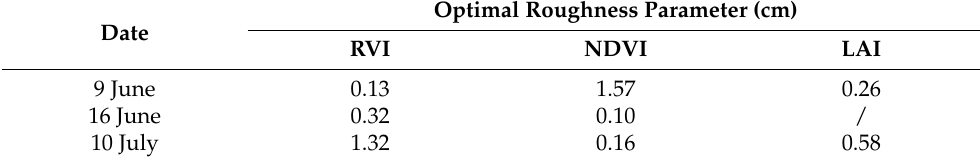
Figure 7. ( a ) Scatterplots between the measured and predicted SMC values on the validation set based on LAI (Ratio method); ( b ) scatterplots between the measured and predicted SMC values on the validation set based on RVI, the same date as LAI (Ratio method). Figure 8. ( a ) Scatterplots between the measured and predicted SMC values on the validation set based on NDVI (Ratio method); ( b ) scatterplots between the measured and predicted SMC values on the validation set based on RVI, the same date as NDVI (Ratio method).